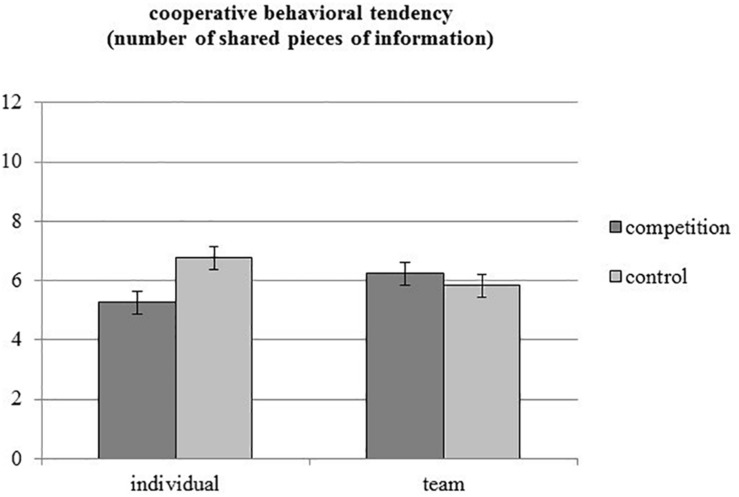
Number of shared pieces of information with uninvolved others by individual versus team athletes in the competition versus control condition (Study 2, N = 116). Error bars denote one standard error around the mean.